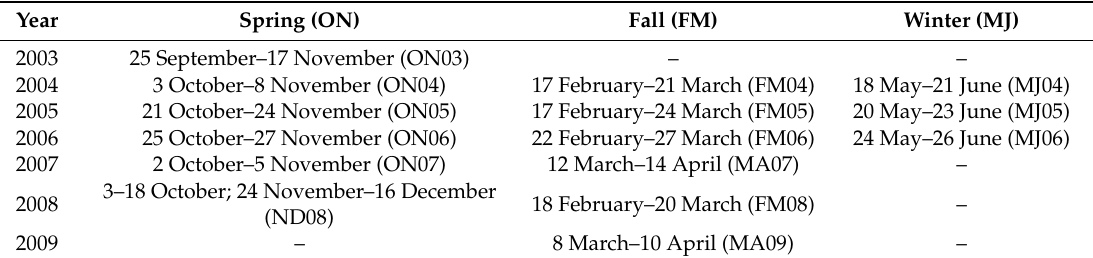
Table 1. The used ICESat measurement periods. The abbreviations given in parentheses in each cell are used throughout the paper to denote the respective